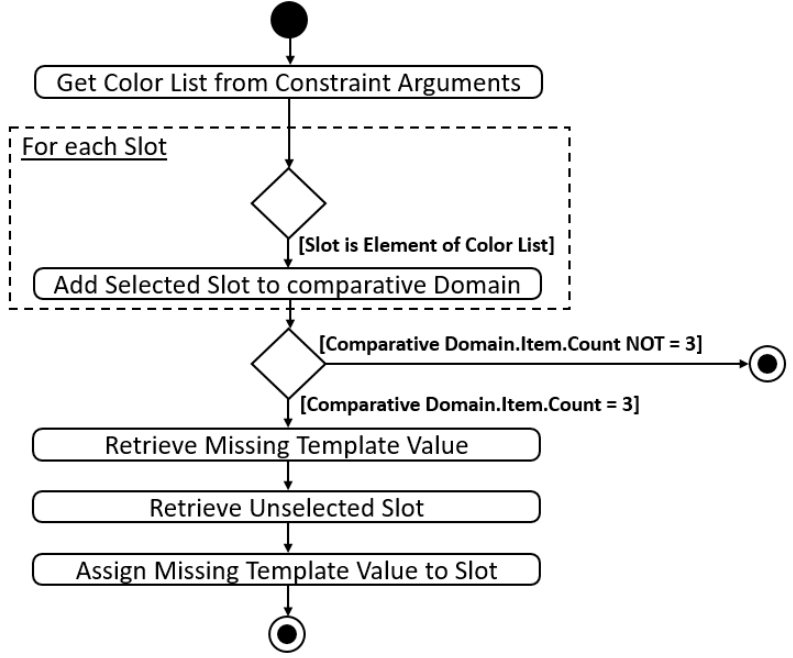
Figure 11. Activity diagram for handling the obligatory assignment of fourth template slot.